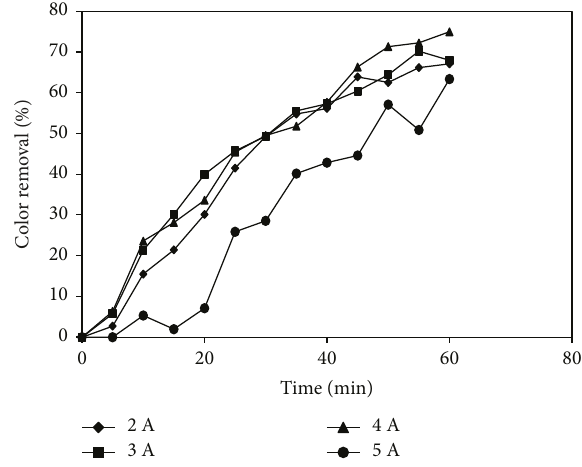
Figure 3: Color removal at di ff erent current intensities: 2 A, 3 A, 4 A, and 5